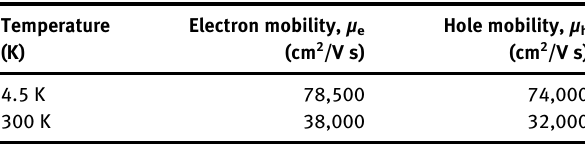
Figure 2: Electrical characteristics of the ADGG-GTeraFET. (a)Two-terminalresistance(R DS )oftheADGG-GTeraFETasafunctionofthetopgates(TG 1 andTG 2 )biasvoltagefordifferentback-gatevoltages at T = 4.5 K. (b) Schematic electrical circuit of the ADGG-GTeraFET for the transport measurements, where a 10 nA pseudo-dc current at 11 Hz, generated by an AC voltage source in series with a 100 M Ω resistance, was injected into the drain contact (current fl ow is indicated by the arrow) and the voltage drop ( v ) was measured between drain and source contacts. Only the asymmetric unit cell was included for simpli fi cation. (c) – (e) Energy-band diagrams of the graphene channel in the asymmetric unit cell showing the charge distributions at zero drain voltage for the different biasing Table  : Electron and hole mobilities in graphene channel of the ADGG-GTeraFET.